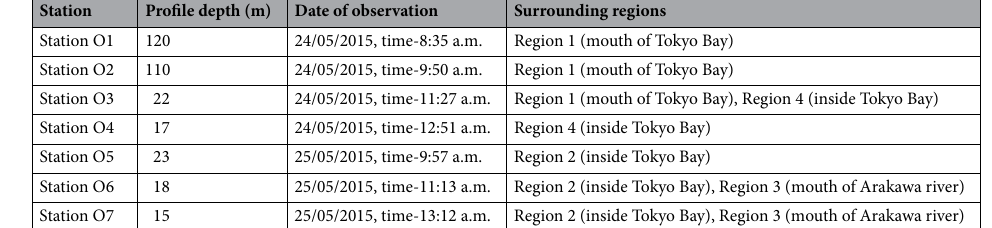
Table 7. Geographical locations and period of observations of phytoplankton at different sampling stations.